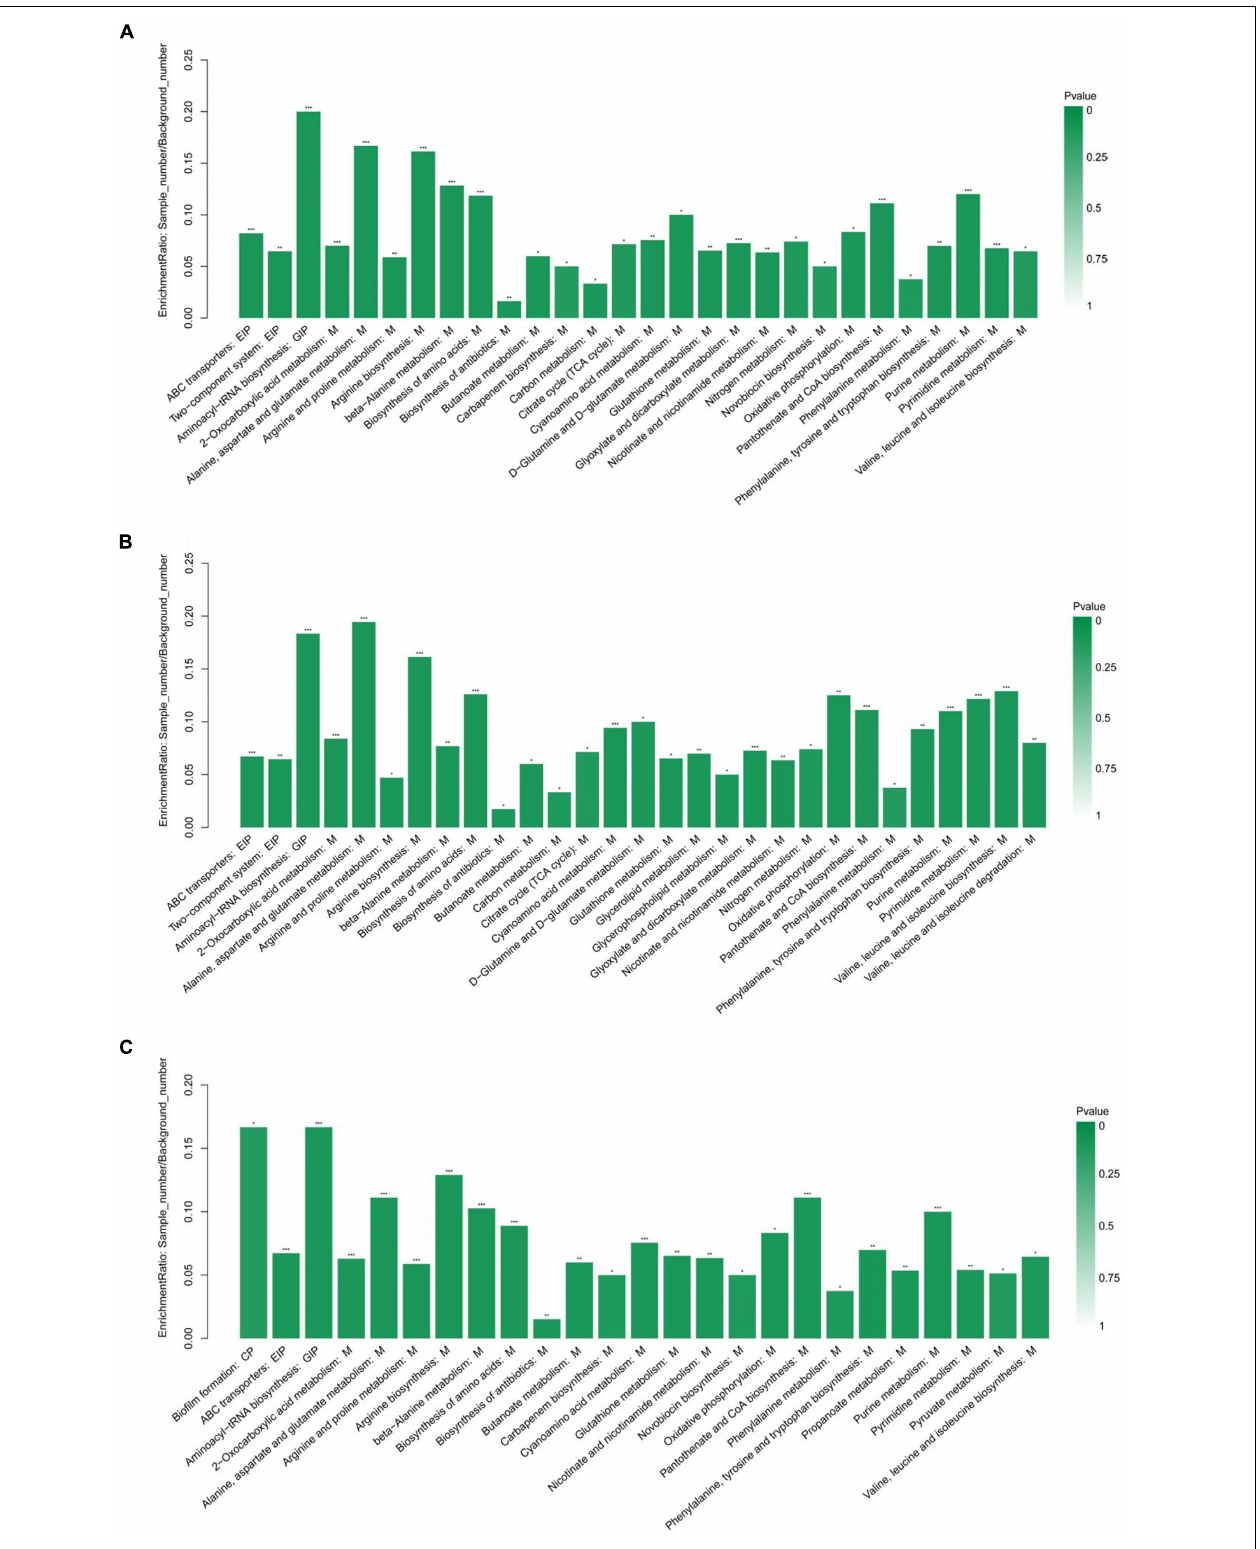
FIGURE 3 | KEGG pathway enrichment analysis of differentially expressed metabolites from E. coli O157:H7 cells. (A–C) Showed the analysis for HVST vs. CT, LVLT vs. CT, and WB vs. CT treated samples, respectively. ∗ represented P < 0.05, ∗∗ represented P < 0.01, and ∗∗∗ represented P < 0.001.